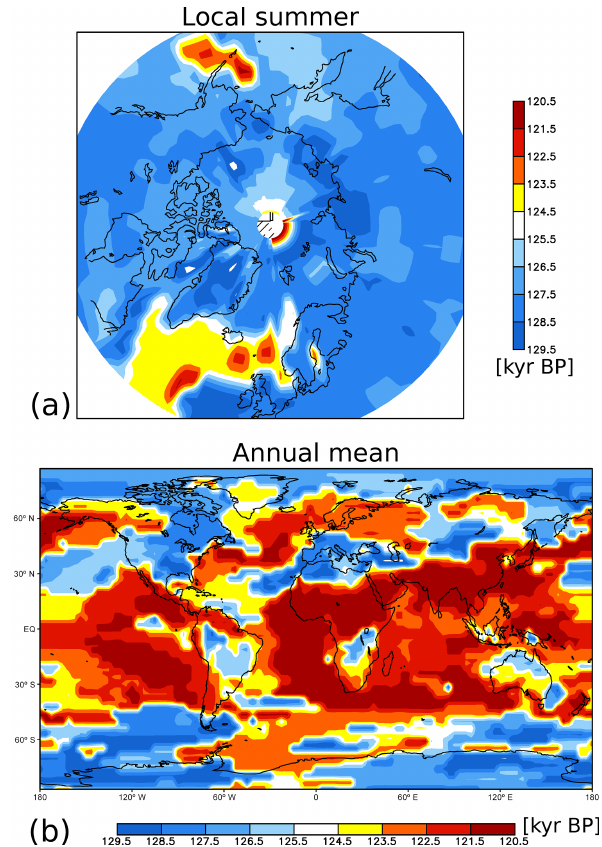
Figure 9. Timing of the maximum Last Interglacial warmth for (a) local summer (warmest 100 warmest months) and (b) annual mean (warmest 100 model years) derived from the LIG-1300m-alb- tr, between 130 and